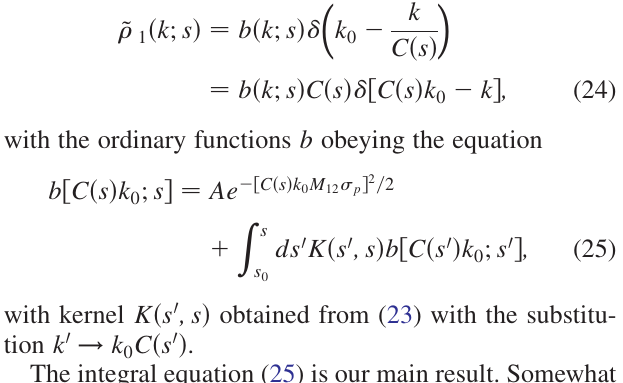
FIG. 3. Compression factor along the beam line. The value at exit is